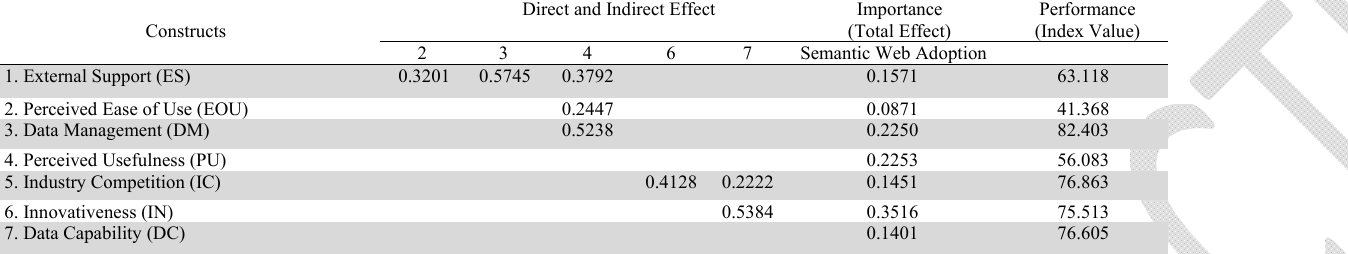
Standardized Direct, Indirect and Total Effects Between Constructions